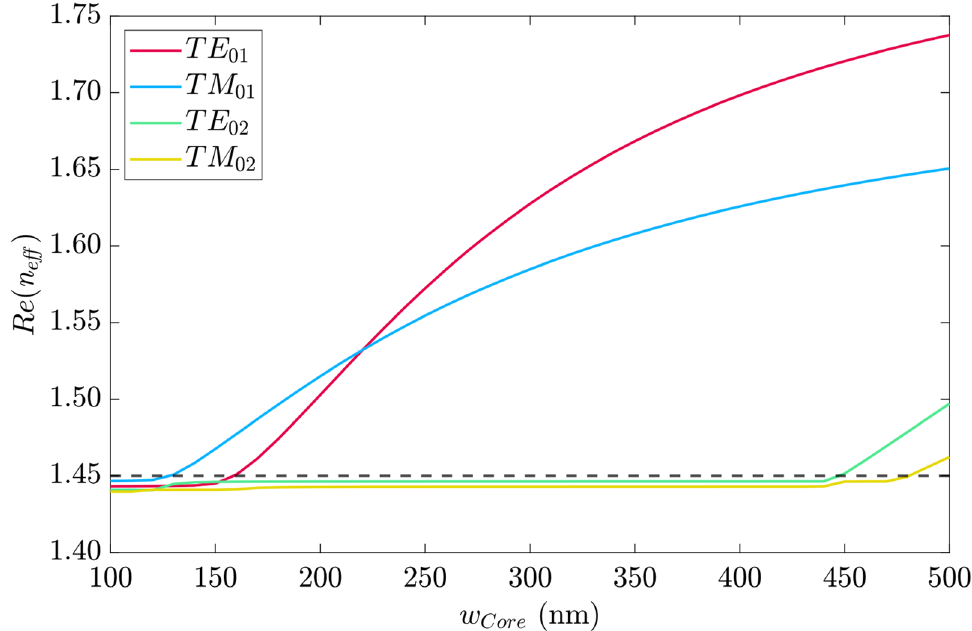
Figure 3. Re ( n eff ) for the first four fundamental modes of the 220 × 350 nm Si 3 N 4 waveguide. To avoid multiple quasi-TM modes guiding and to allow the highest power transmission, the width w wg = 400 nm was used for the subsequent analysis. The complex refractive index of the metal layer was obtained from the Drude–Lorentz model, shown in Figure 4, using Equation (6) and converted to a refractive index with the √ (cid:101) . The parameters used in are Equation (6) are listed in Table 2 [37]. At λ 0 = relation n = 633 nm, the gold complex refractive index is 0.3114 + j3.1405.